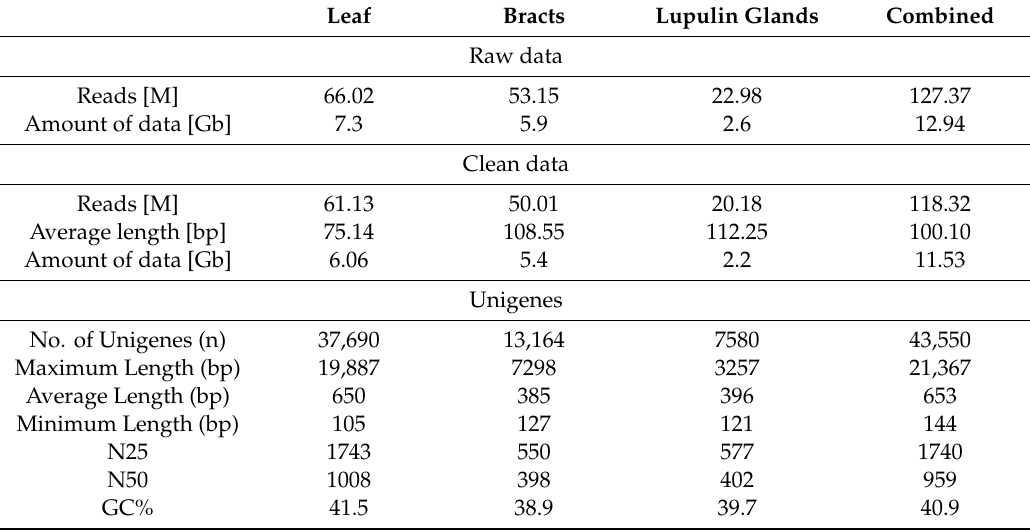
Table 1. Sequencing statistics for leaf, bracts, lupulin